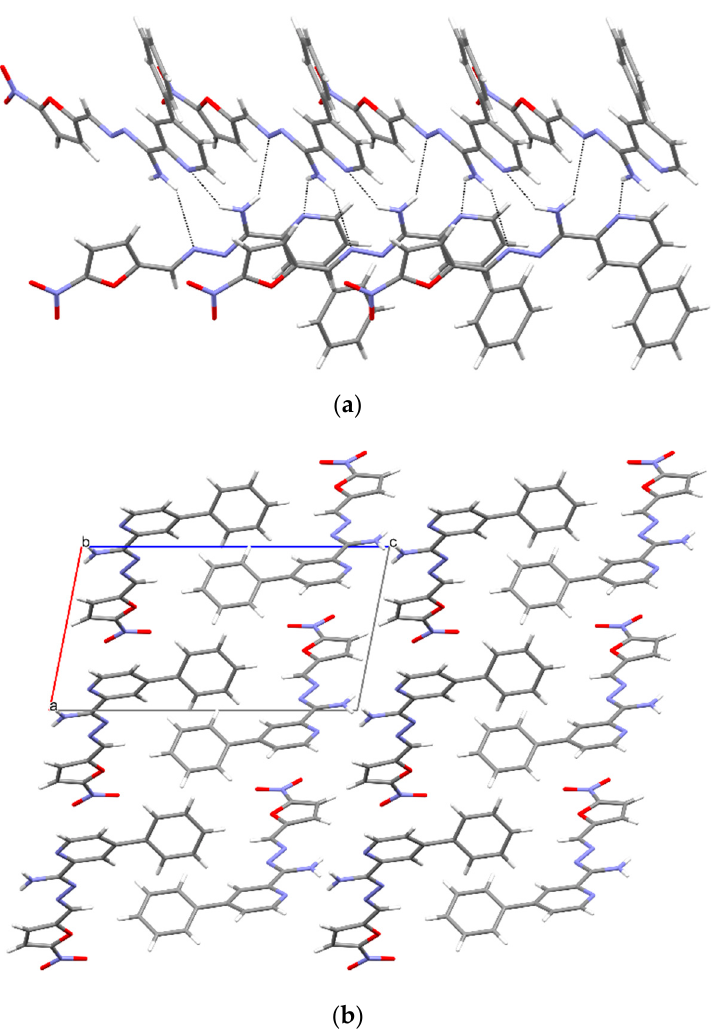
Figure 7. ( a ) Intermolecular hydrogen bonds in compound 3a . ( b ) The crystal packing of compound 3a (a, b, c–unit cell).